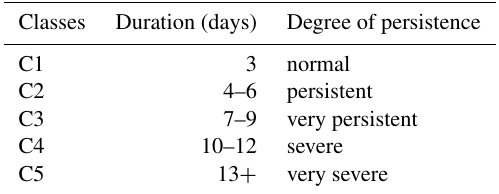
Table 3. Classification of heat waves based on the